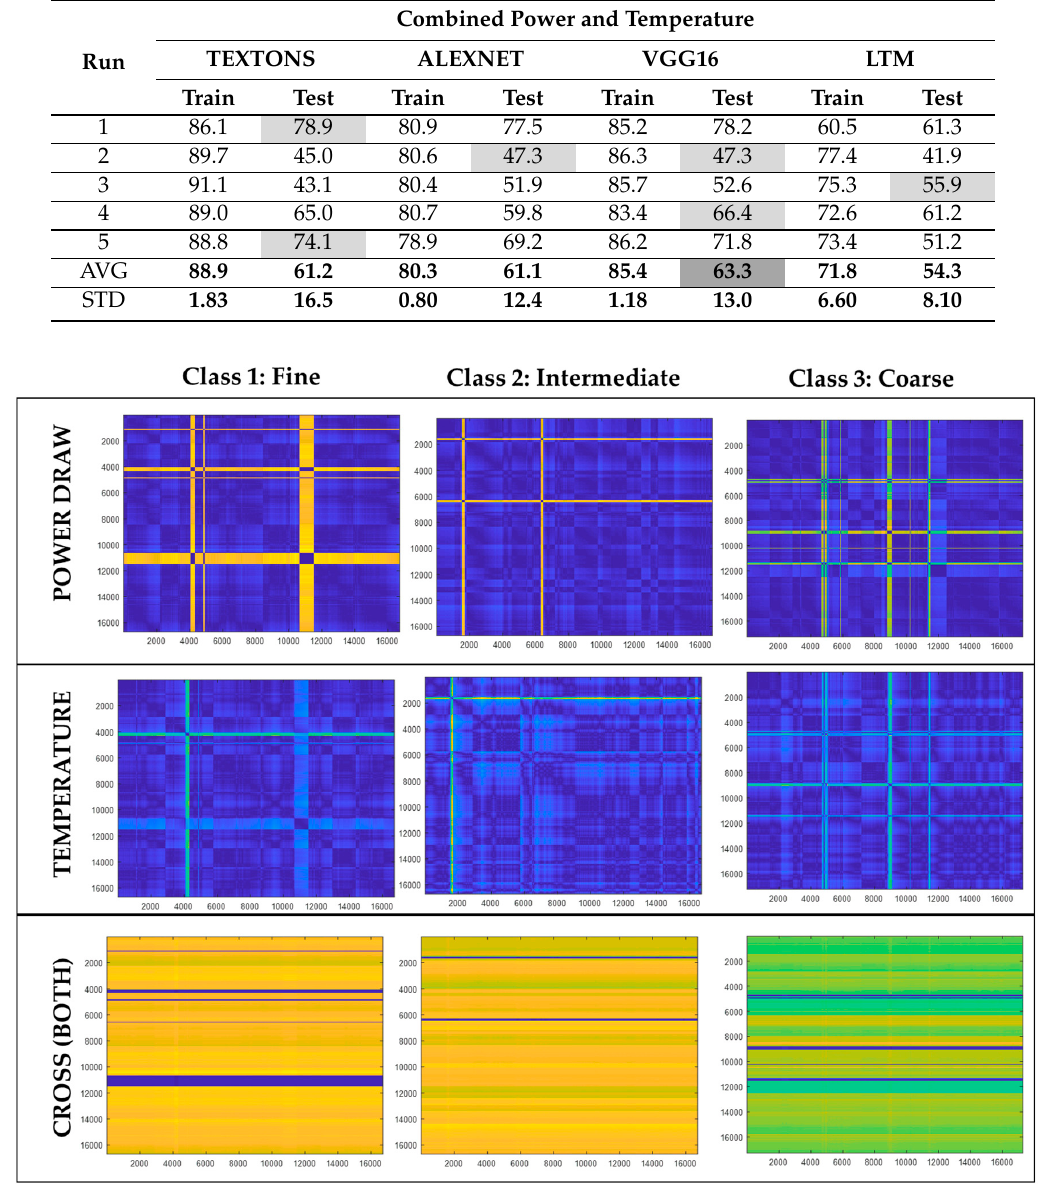
Table 6. Results of classification (% correct) with predictor sets derived from combination of the mill temperature and power data and use of a cubic kernel support vector machine.